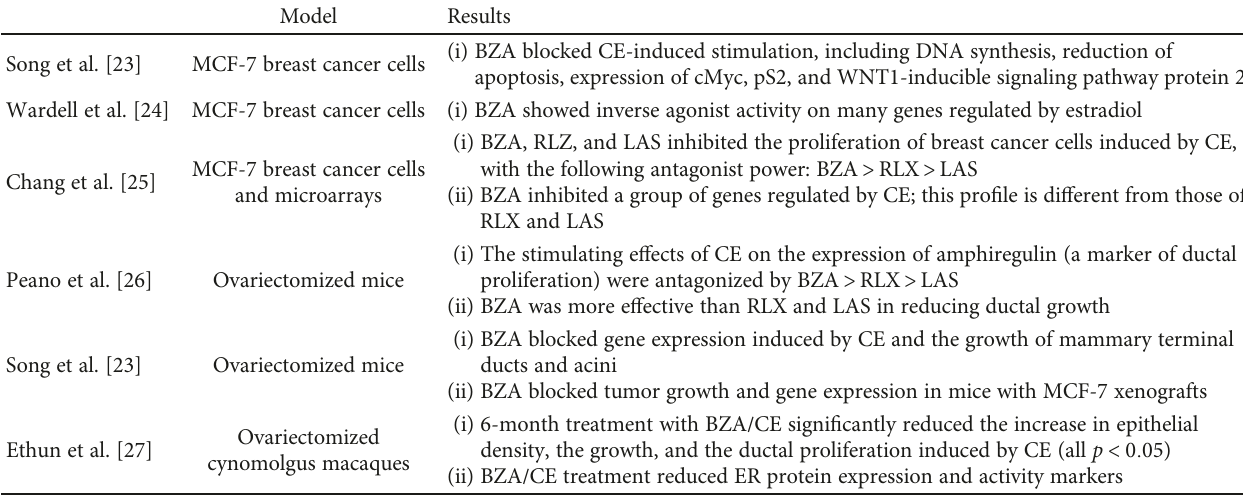
Table 2: Preclinical studies on breast tissue.